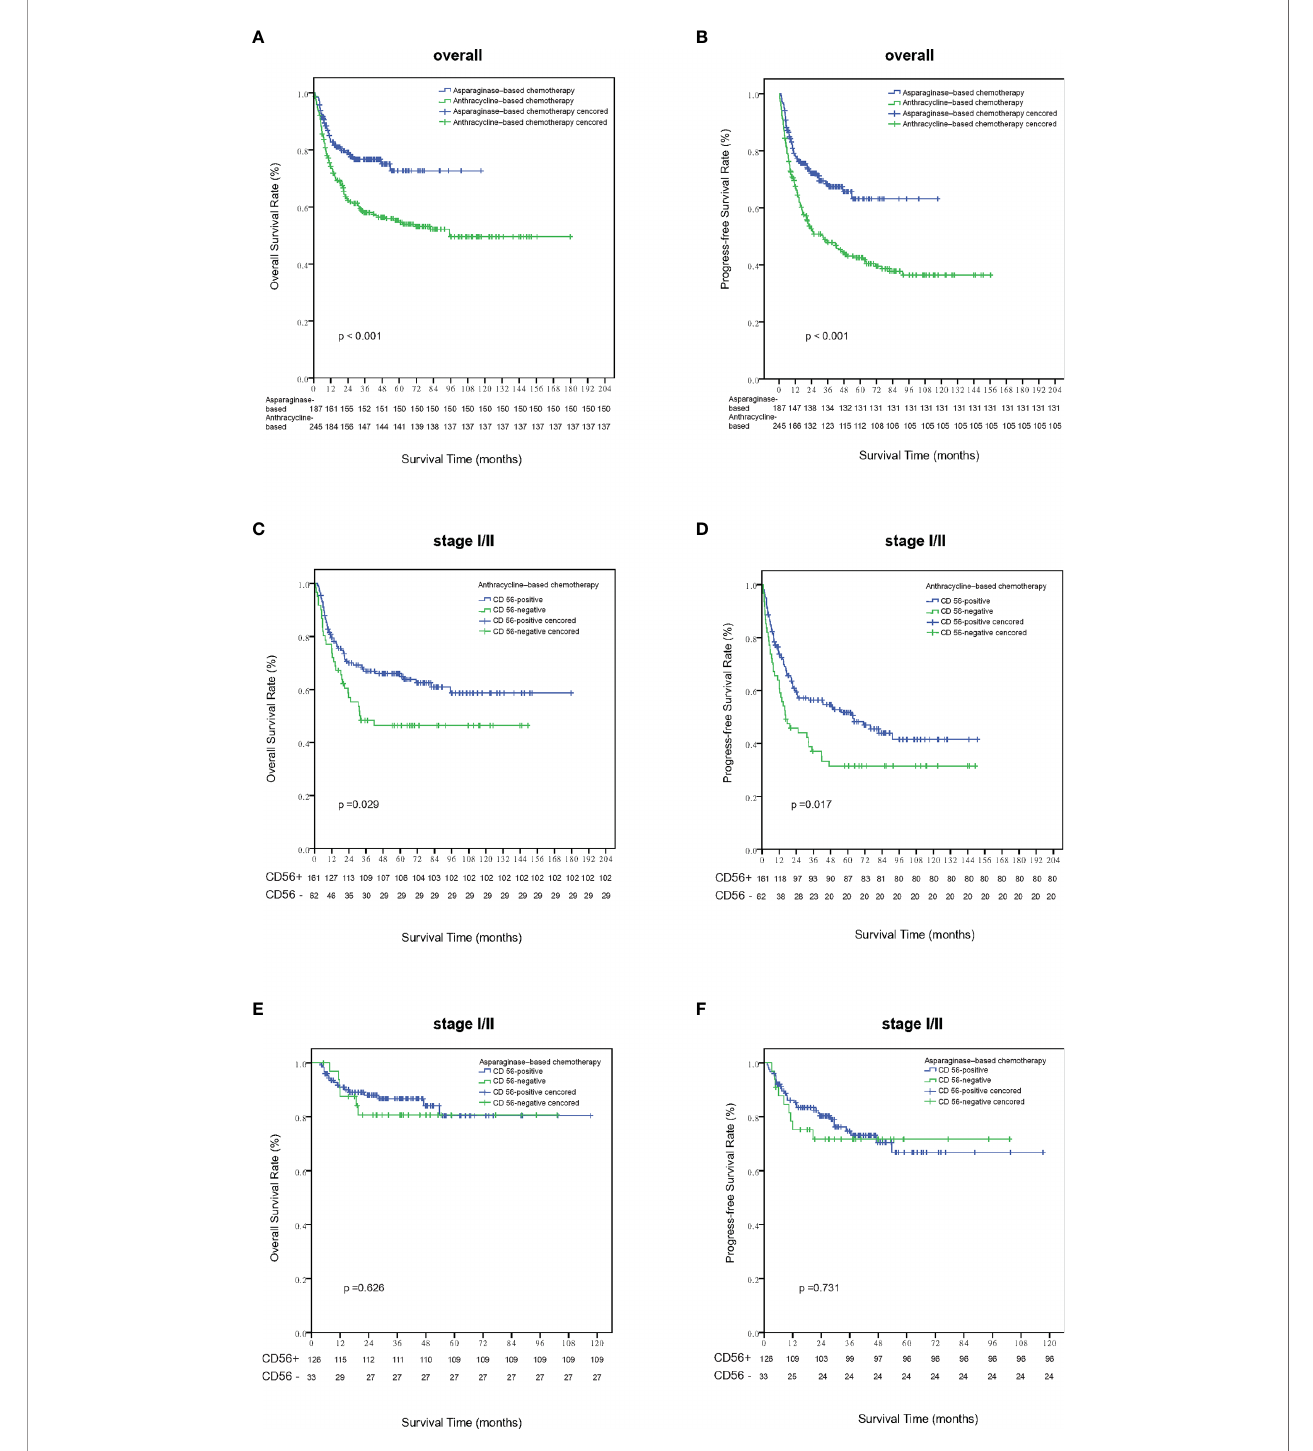
FIGURE 4 | Survival analysis according to different treatment strategies. Patients treated with asparaginase-based chemotherapy had signi fi cantly better overall survival (A) and progression-free survival (B) than those treated with anthracycline-based regimens. Out of patients with stage I-II disease who were treated with anthracyline-based chemotherapy, patients who were CD56 negative had signi fi cantly inferior overall survival (C) and progression-free survival (D) than those CD56 positive ones. Out of patients with stage I-II disease who were treated with asparaginase – based chemotherapy, the expression status of CD56 was not related with overall survival (E) and progression-free survival (F)